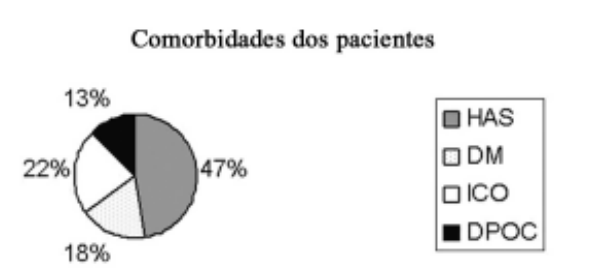
Fig. 1 - Comorbidades apresentadas pelos pacientes analisados. HAS - Hipertensão arterial sistêmica. DM - Diabete melito. ICO - Insuficiência coronariana. DPOC - Doença pulmonar obstrutiva